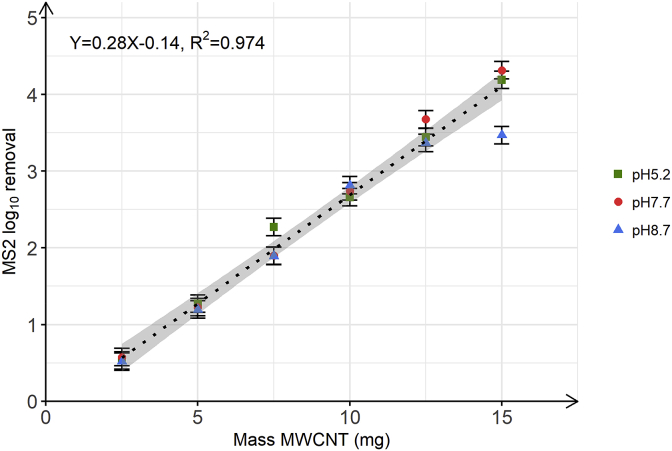
MS2 log10 removal as a function of MWCNT mass used during batch experiments. Green squares, red circles and blue triangles correspond to the batch experiments performed at pH 5.2, 7.7 and 8.7, respectively. The black dotted line corresponds to the single linear regression fitted to all the data at pH 5.2, 7.7 and 8.7, since pH had no significant effect on MS2 LRV. The grey zones represent the 95% confidence interval. The batch experiments were performed in duplicate at an initial MS2 concentration of 106 PFU/mL. Error bars represent laboratory precision calculated using a pooled standard deviation, or weighted average of standard deviations calculated for all groups of samples, from the sets of duplicate samples. (For interpretation of the references to colour in this figure legend, the reader is referred to the Web version of this article.)